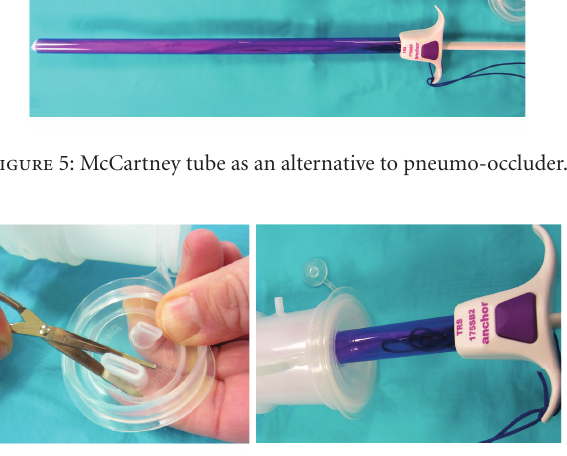
Figure 6: Cut tip to insert anchor bag device within the McCartney Tube.